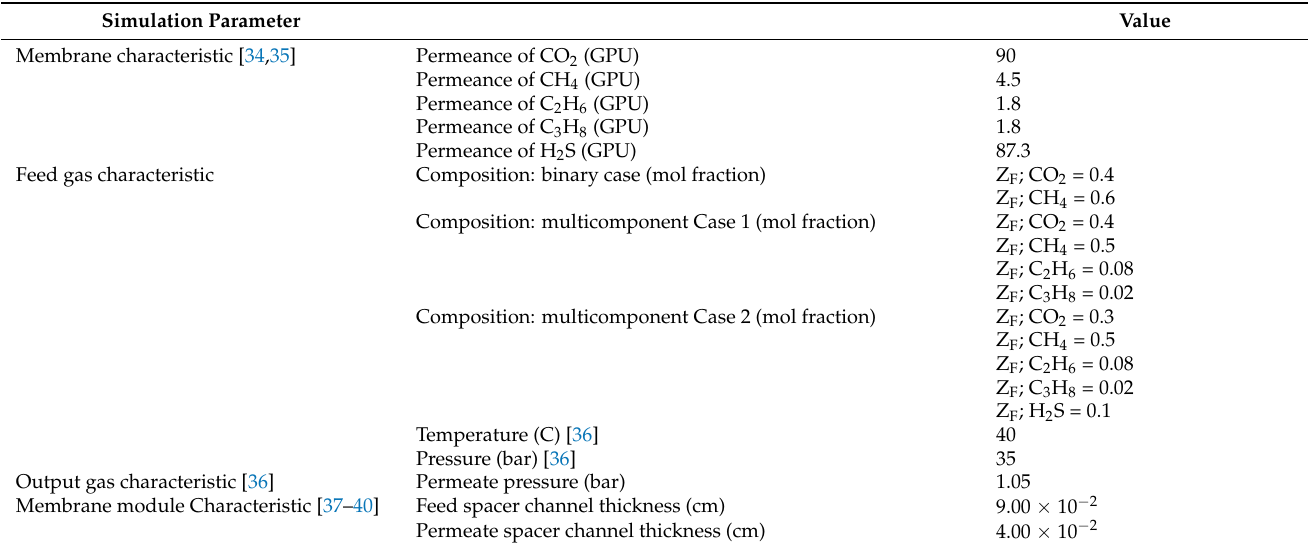
Table 4. Input parameters used for the simulation of membrane case studies. Simulation